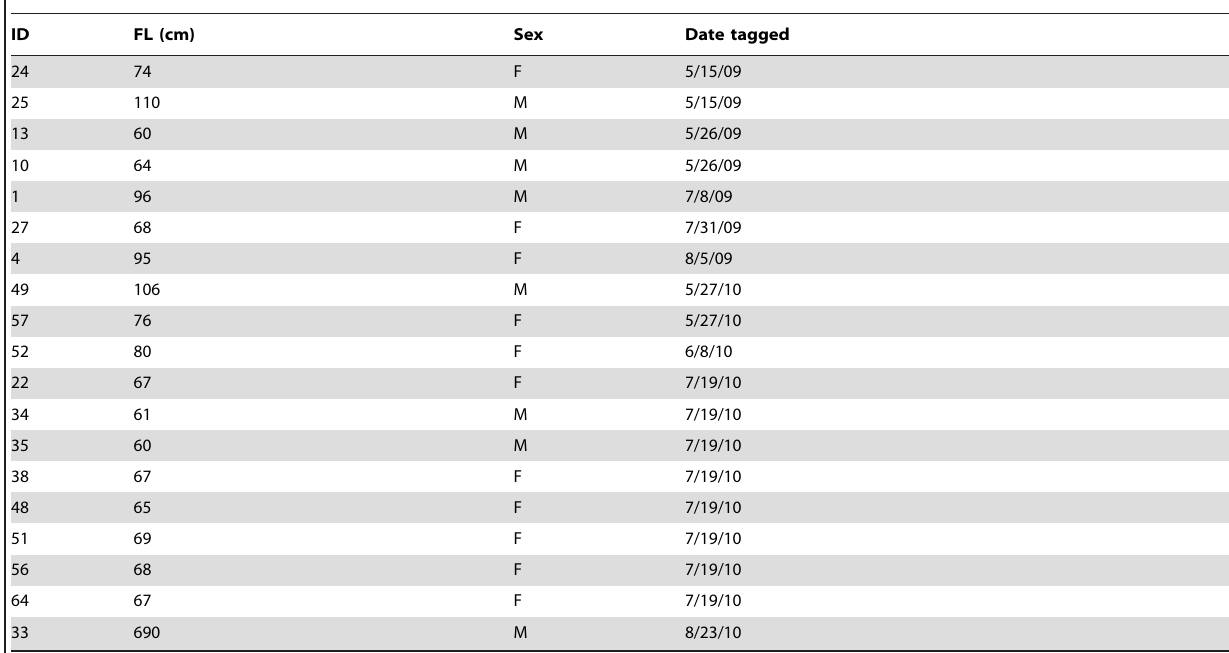
Table 1. Biological data for tagged bull